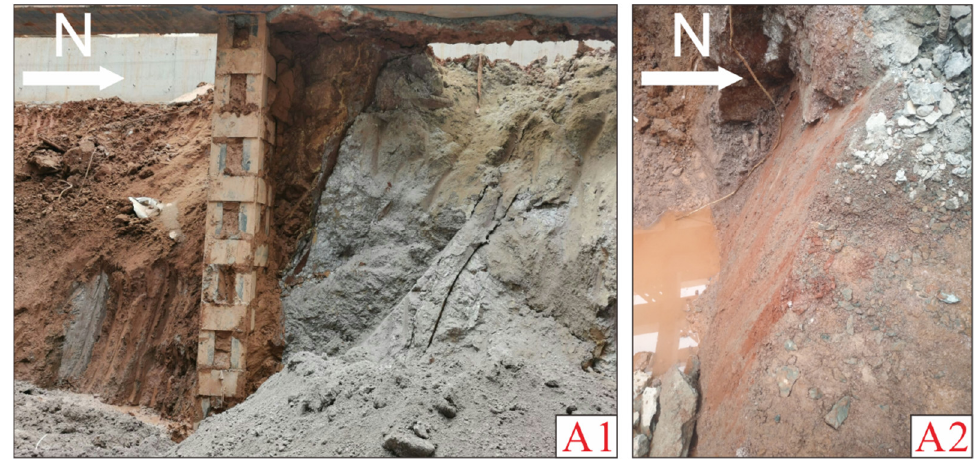
Figure A1. Photos of sample locations in the deep subway excavation at Jiangtai Road subway station. ( A1 ) Cretaceous sediments on the left and volcanic rocks on the right; ( A2 ) fault plane (the plane dips to the south with a dip angle of 52°).